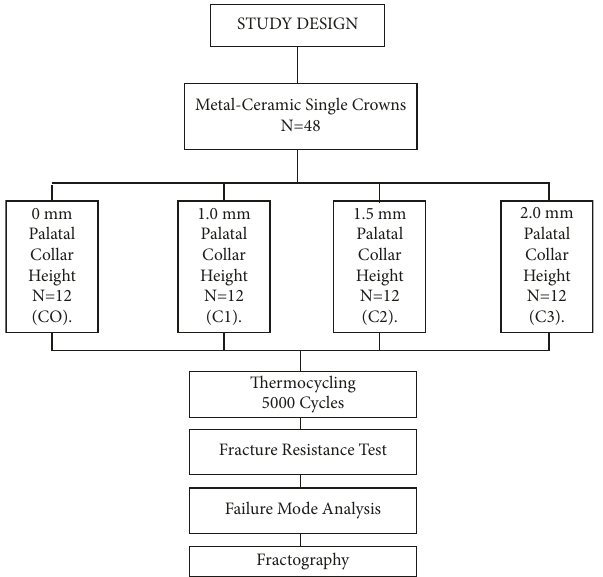
Figure 3: Study design. Figure shows the groups, number of crowns in each group and number of samples